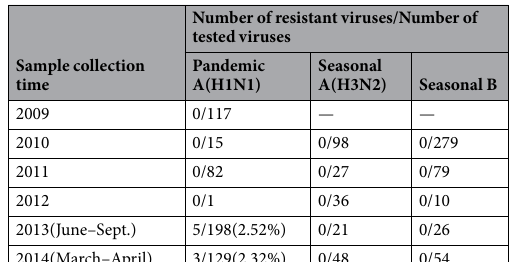
Sample collection time